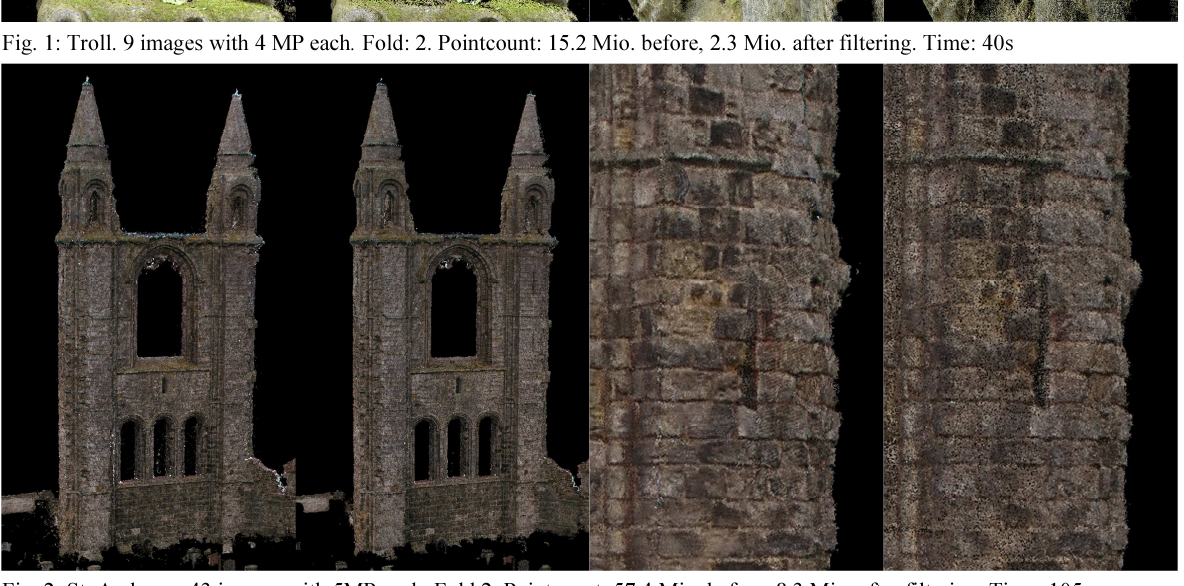
Fig. 2: St. Andrews. 43 images with 5MP each. Fold 2. Pointcount: 57.4 Mio. before, 8.3 Mio. after filtering. Time: 105s